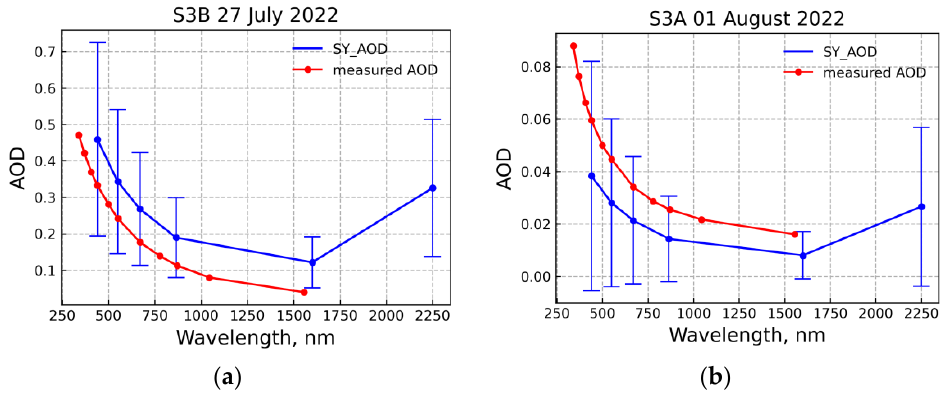
Figure 3. AOD spectra from SYN_AOD products (blue lines) and in situ measurements (red lines): ( a ) 27 July 2022; ( b ) 1 August 2022. The vertical lines show the AOD uncertainties equal to one standard deviation.